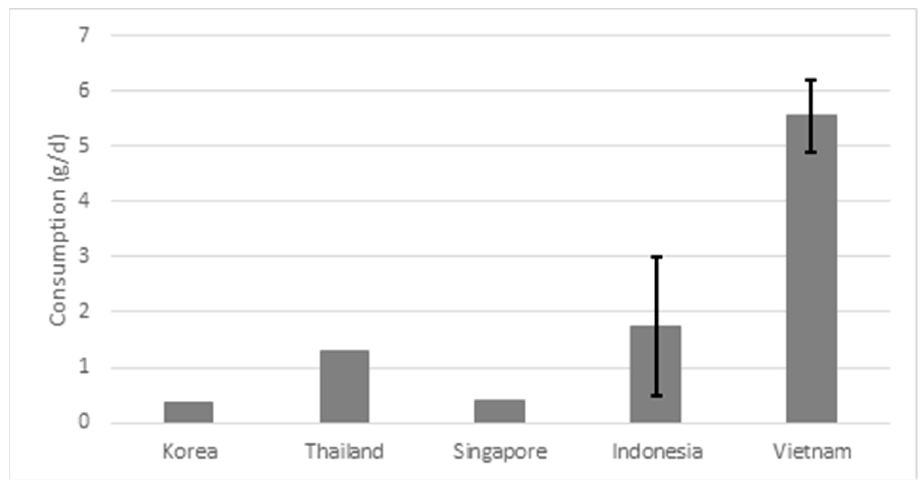
Figure 3. Average consumption of seasonings and bouillon cubes in g/day. The error bars represent the highest and lowest value found for the country.